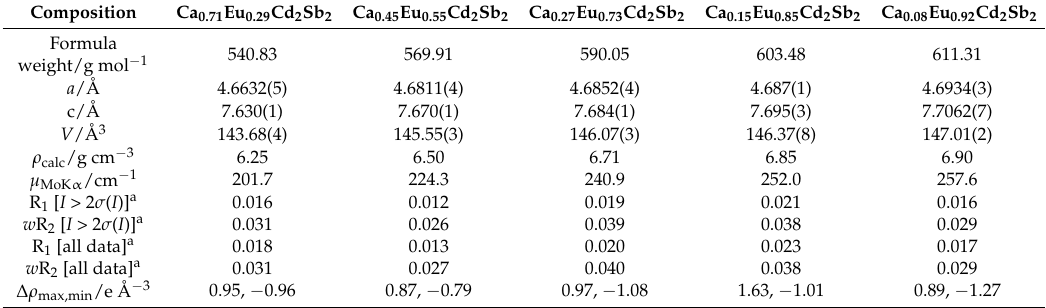
Table 1. Data collection details and selected crystallographic data for Ca 1 − x Eu x Cd 2 Sb 2 (space group P 3 m 1 (No. 164), Z = 1, T = 200 K, Mo K α λ = 0.71073 Å). The estimated standard deviations on the refined compositions are ± 0.01 or better.